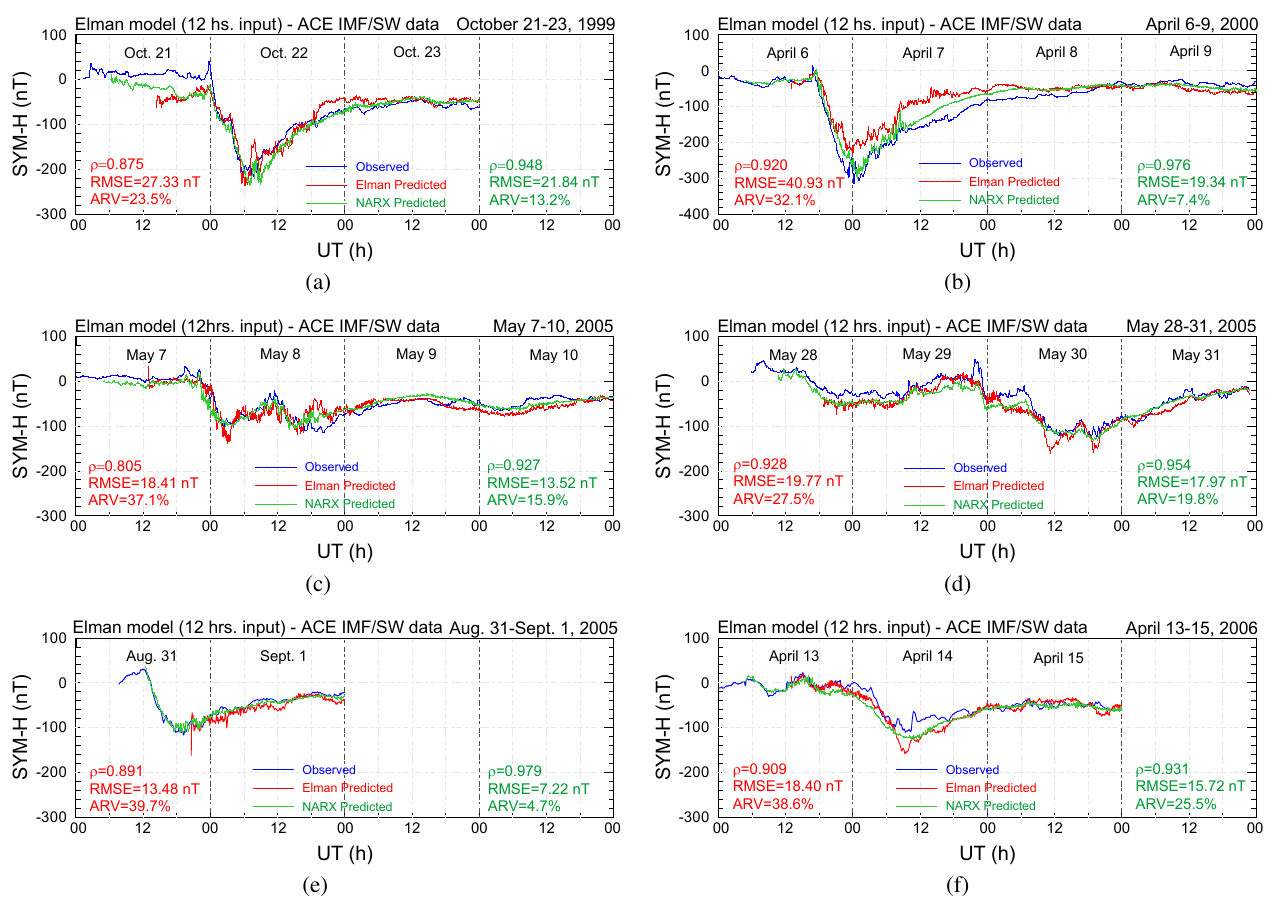
Fig. 9. Comparison of observed SYM-H index with that predicted by Elman neural network with 720 min length history IMF/SW parameters as input for each testing storm event whose IMF/SW data are from ACE. The SYM-H indices predicted by NARX model are also plotted in the corresponding figures by green lines for a comparison of the two models.